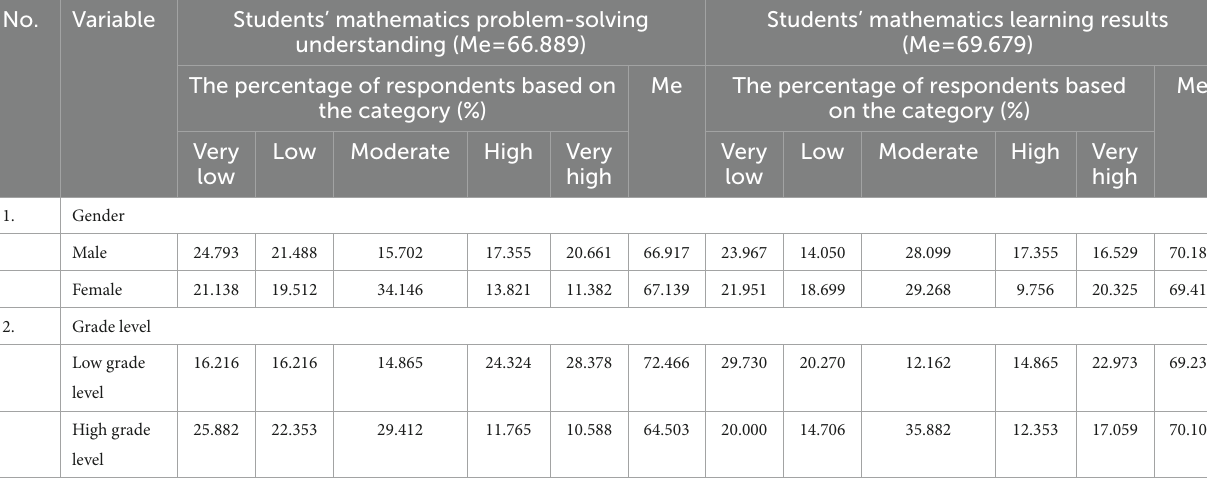
TABLE 2 Students’ mathematics problem-solving understanding and their mathematics learning results.